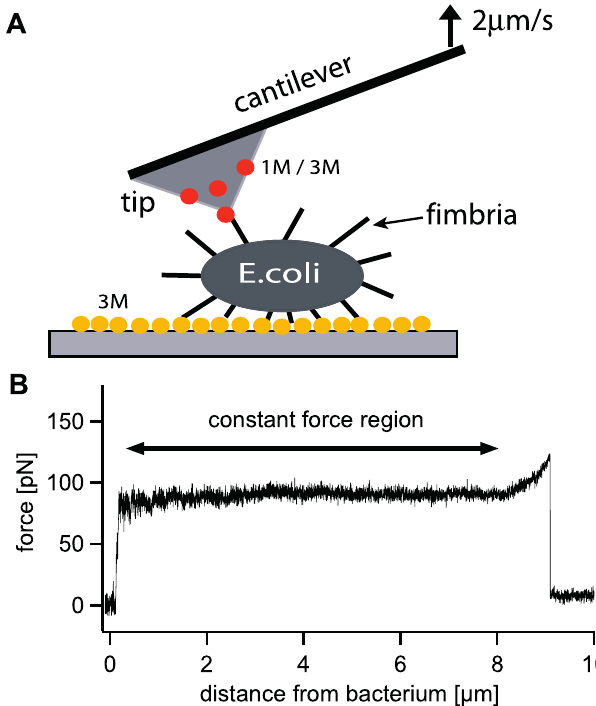
Figure 1. Force Measurements on Type I Fimbriae of E. coli (A) Experimental setup. The tip (gray) of an AFM cantilever is coated with 1M-BSA (red) or 3M-RNAseB (yellow). An E. coli bacterium is attached to a 3M-covered glass surface. After the bacterium is approached with the AFM tip, one or multiple fimbriae can bind. The cantilever base is then pulled away from the bacterium at a constant velocity. (B) Force/extension curve for a single fimbria measured at a constant velocity of 2 l m/s. When pulled at various constant velocities, fimbriae extend to multiple times their original length of ; 0.7 l m. The force profile shows three distinct regions: first, the force increases quickly with separation. Second, this is followed by a constant-force region where the AFM tip can be pulled away for several micrometers. Third, the force then increases nonlinearly before the bond between the mannose coated AFM tip and the fimbria finally breaks. (The spring constant of the cantilever used in this pull was 7.9 pN/nm.) DOI: